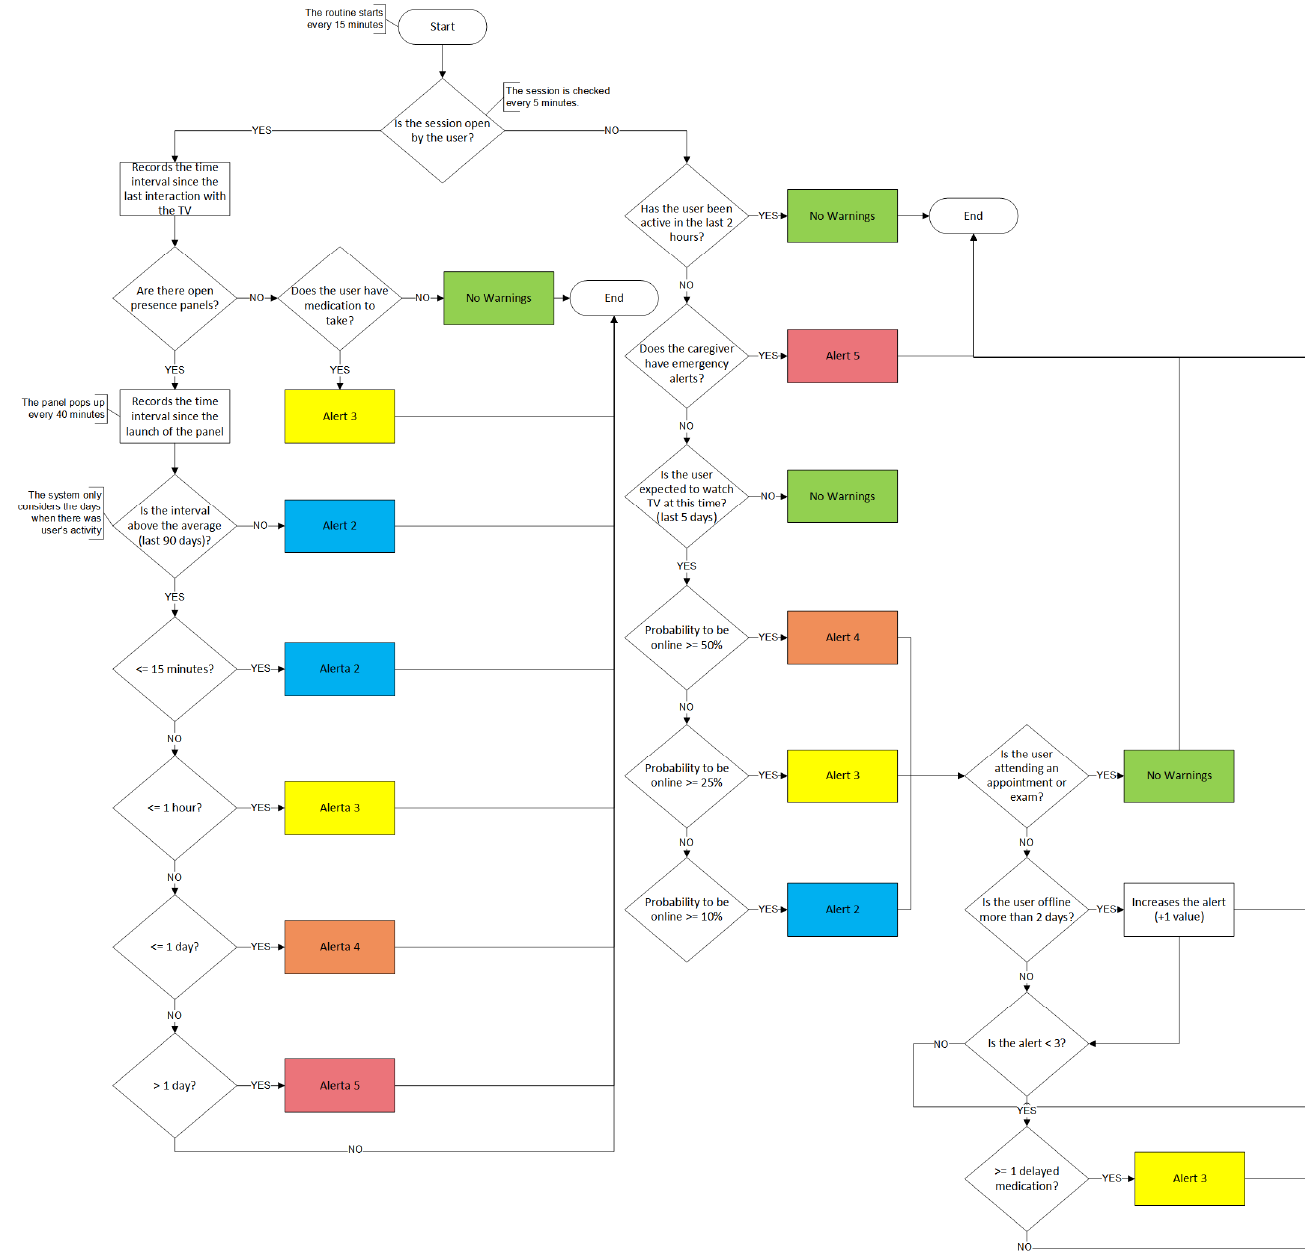
Figure 18. Analysis process of the warning algorithm.